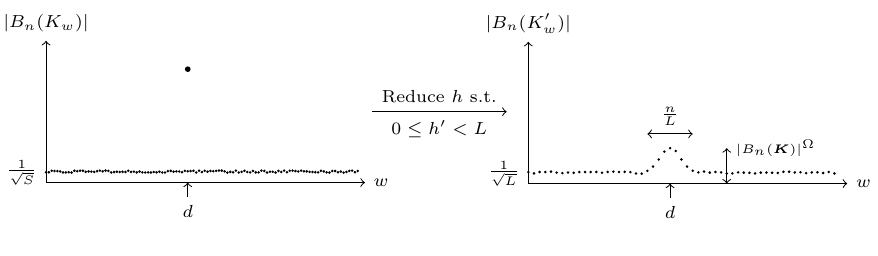
Figure 5: The effect of range